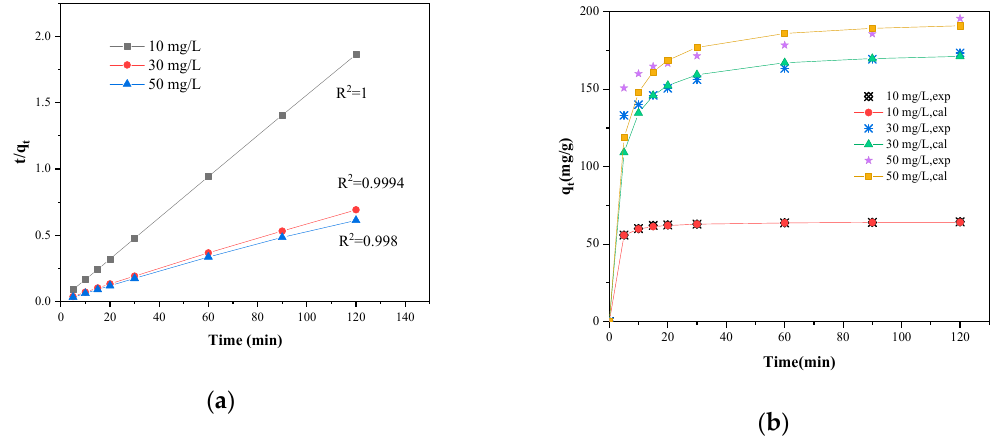
) for the adsorption of MB (cid:1857)